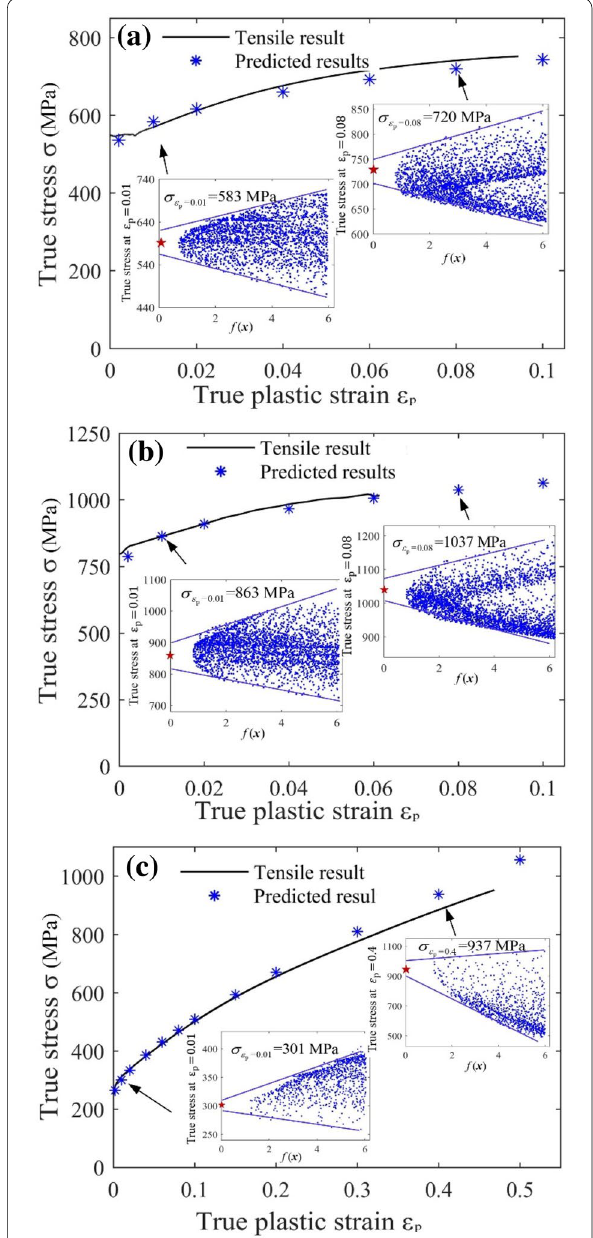
Figure 8 Flow curves measured from experimental tensile results and predicted using database method with experimental indentation